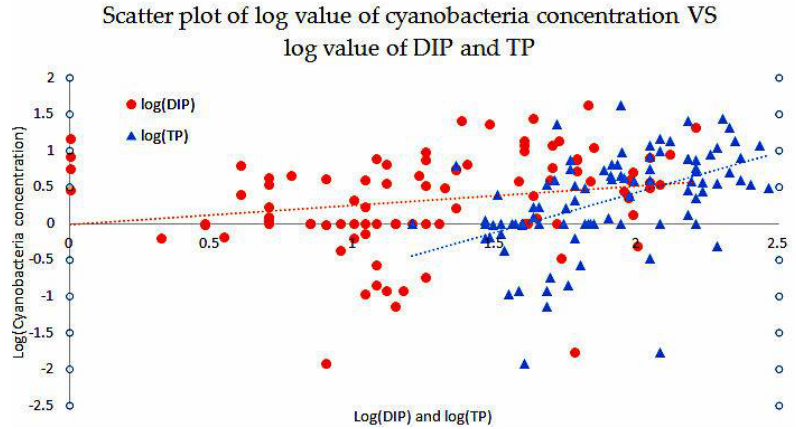
Figure 3. Comparison of the relation of dissolved inorganic phosphorus (DIP) with cyanobacteria biomass (dot red) and TP with cyanobacteria biomass (triangle blue).